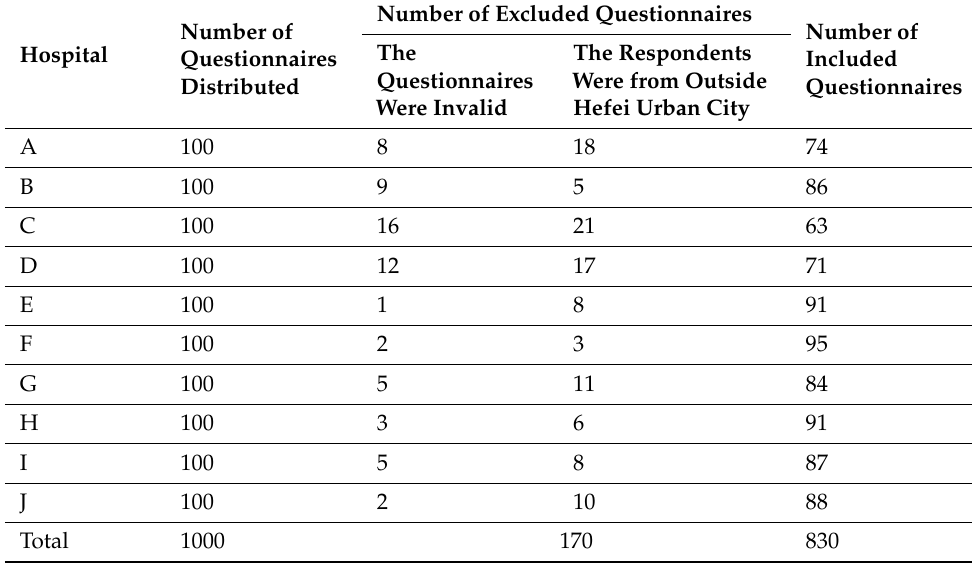
Table A2. Number of questionnaires of each hospital.